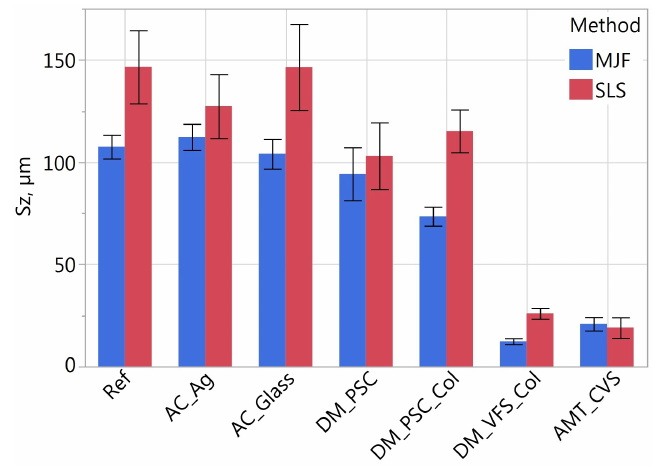
Figure 12. Maximum height Sz of measured samples.